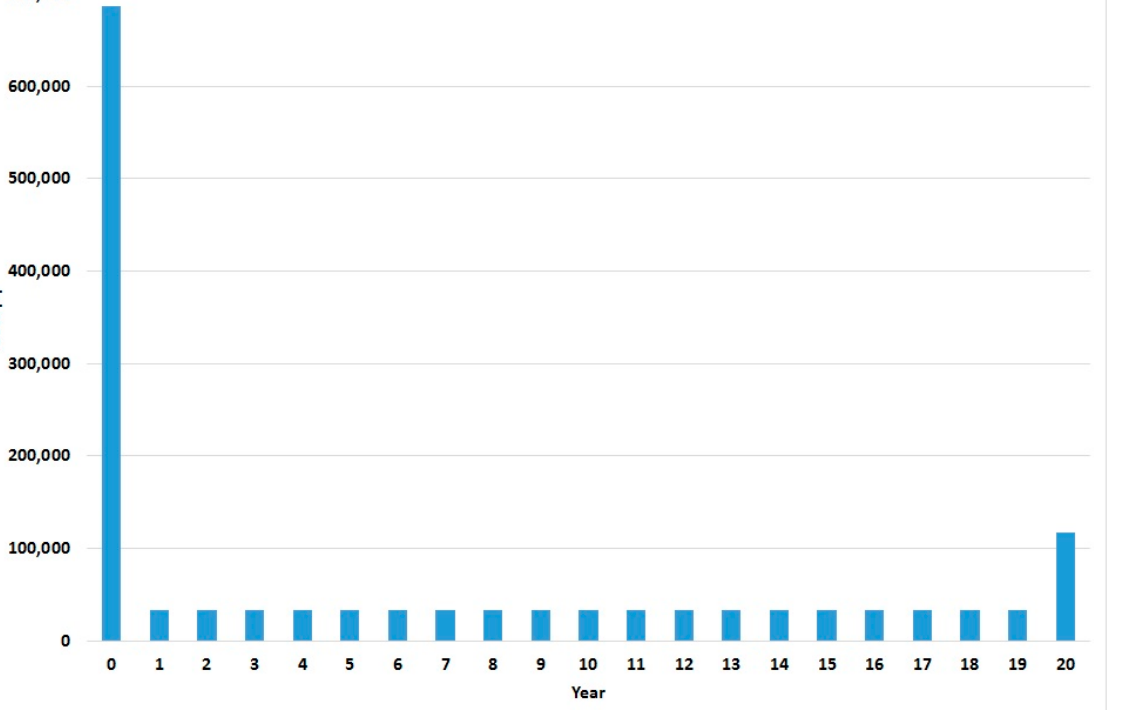
Figure A1. Deterministic costs for the full repowering case per MW installed and year.